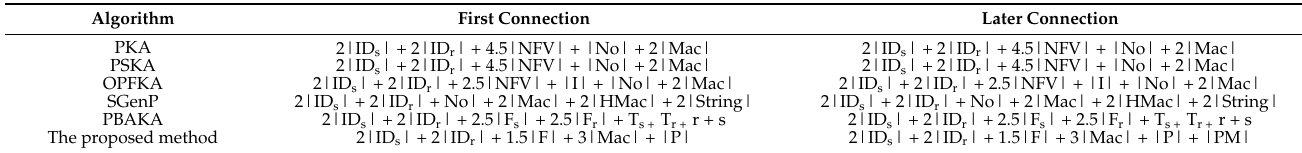
Table 8. Memory cost for first/later connections.